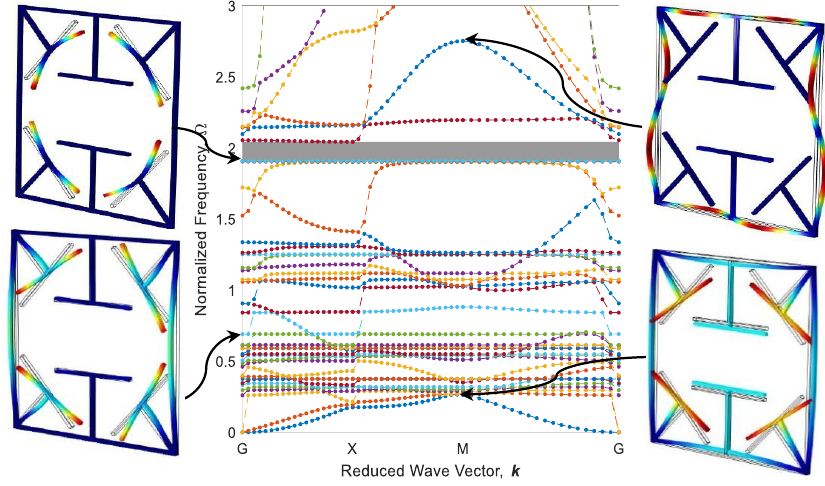
Figure 11. Band structure and mode shapes of the diagonal metastructure.